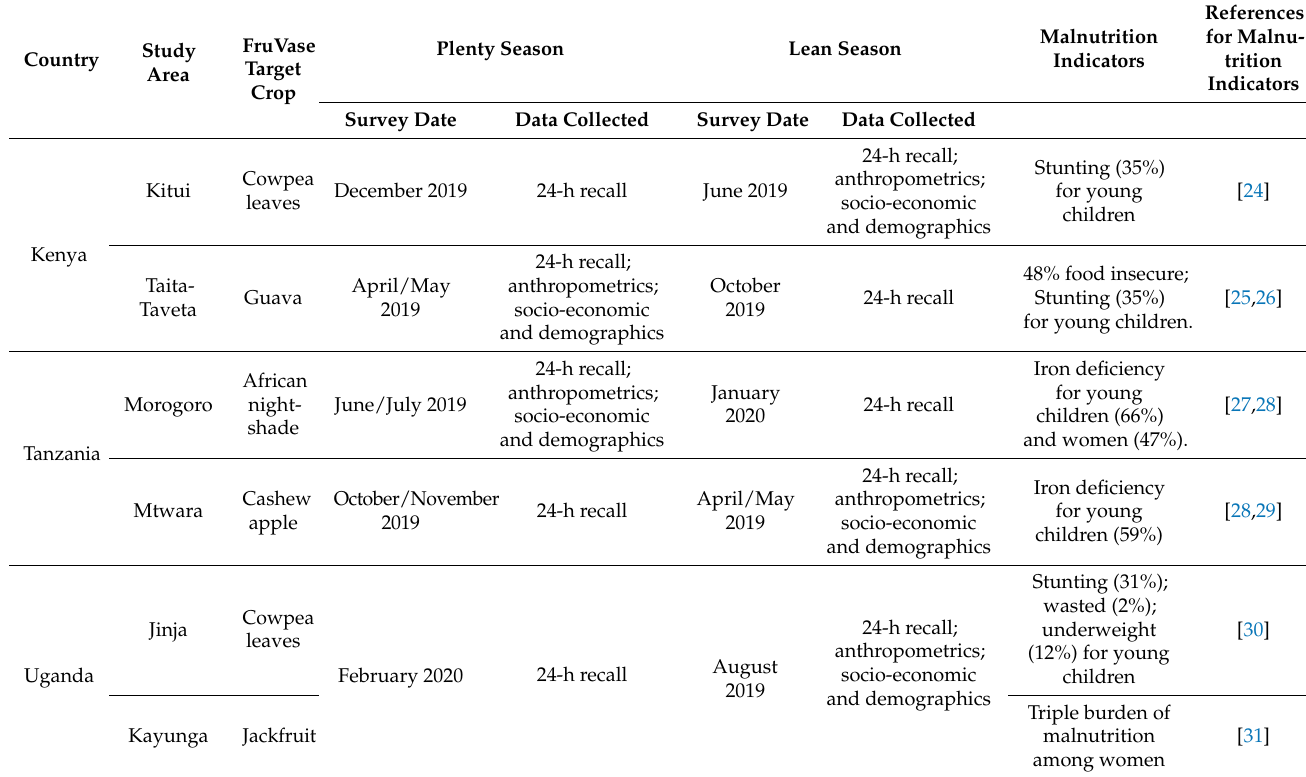
Table 1. Survey timelines, data collected, and malnutrition indicators across the six rural study sites in Kenya, Tanzania, and